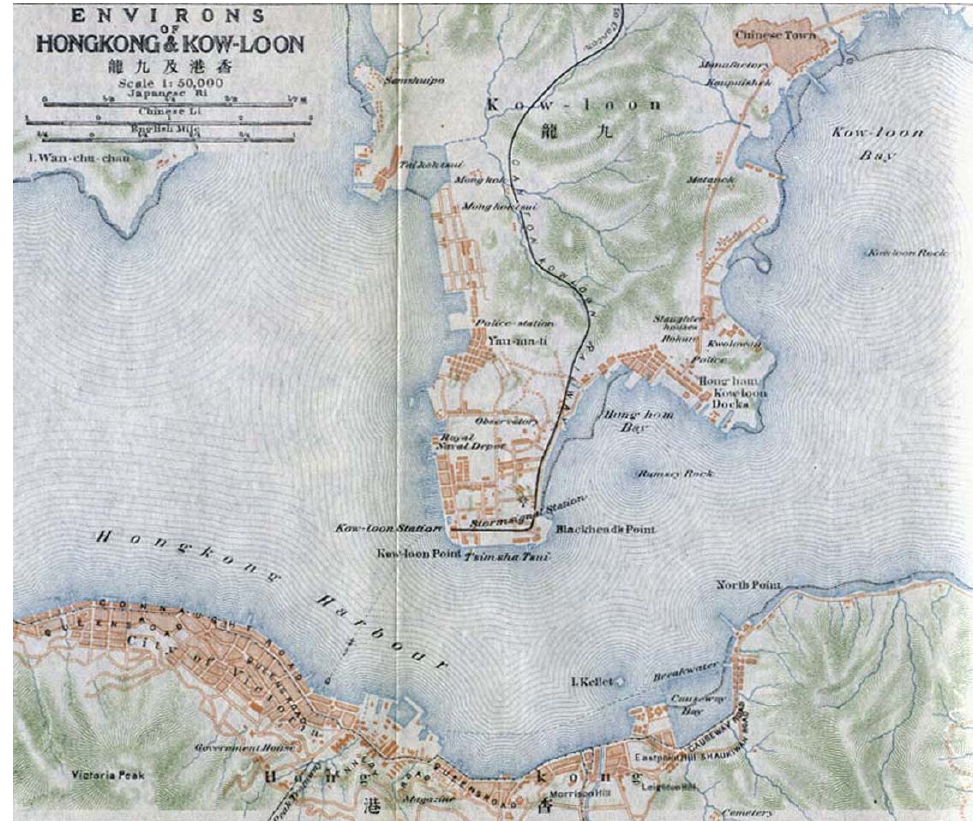
Figure 3. A map of the Hong Kong Island and Kowloon region in 1915; the KWC is in the upper- right corner of the map (marked “Chinese Town”) (https://commons.wikimedia.org/wiki/File:Victoria_City_and_Kowloon_1915.jpg, public domain, accessed 11 March